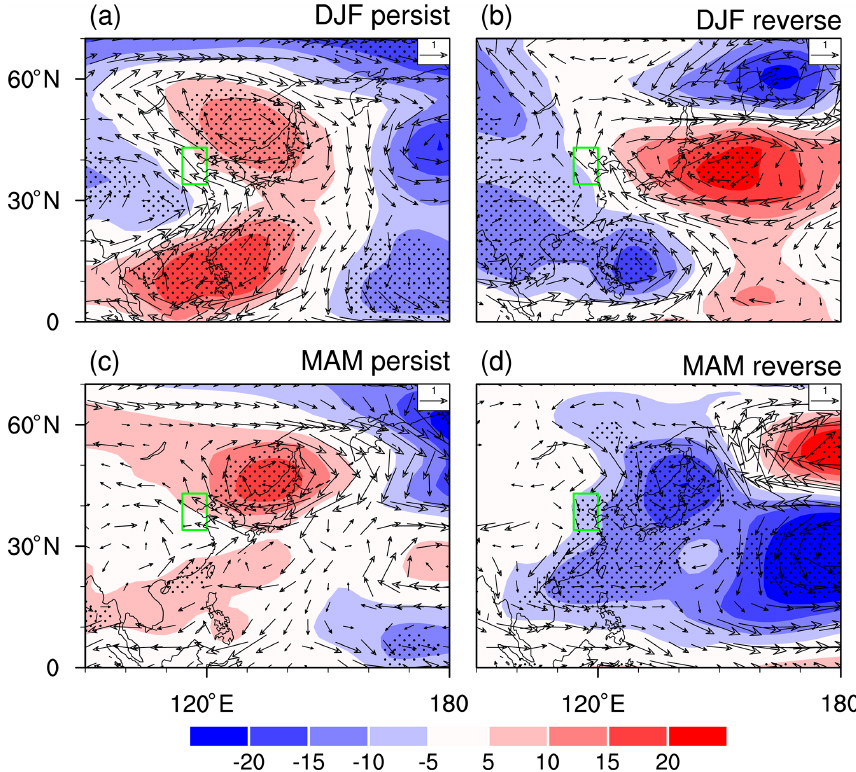
Figure 4. Composite anomalies of 850hPa winds (vectors, unit ms − 1 ) and streamfunction (shading, unit 10 5 m 2 s − 1 ) in (a, b) winter and (c, d) spring in the (a, c) persistent years and the (b, d) reverse years. Stippled regions indicate streamfunction anomalies that are statistically significant at the 5%